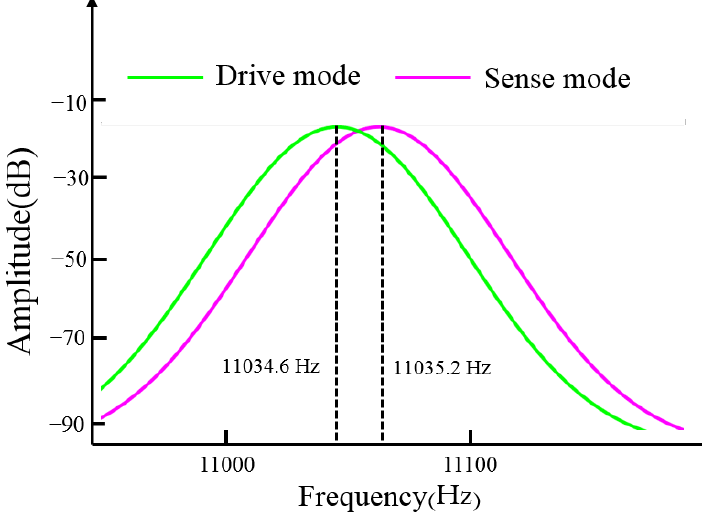
Figure 3. The vibration mode of MEMS gyroscope: ( a ) drive mode; ( b ) sense mode; ( c ) irrelevant mode; ( d ) irrelevant mod; ( e ) irrelevant mode; ( f ) irrelevant mode.